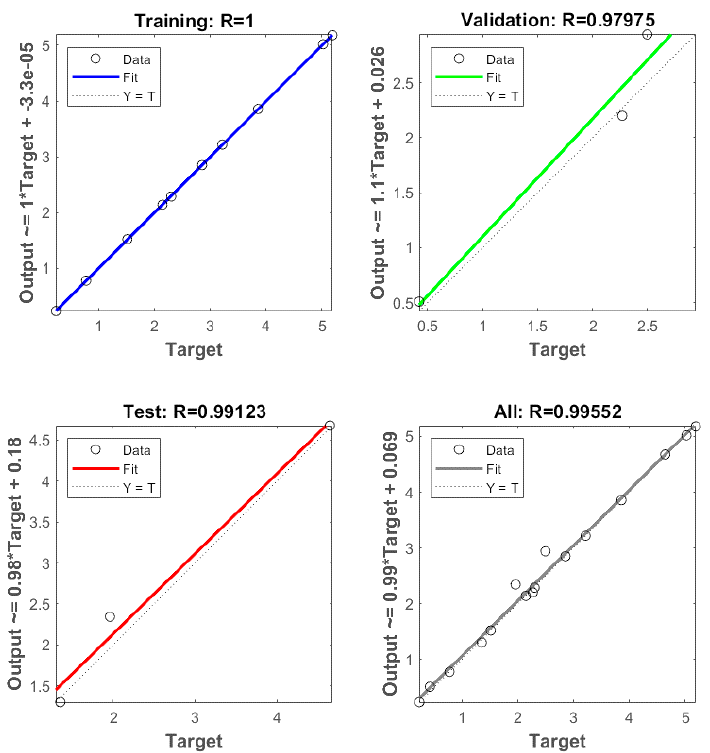
Figure 8. Coefficient of correlation (R) values of training, validation testing and overall datasets, for tensile strength.